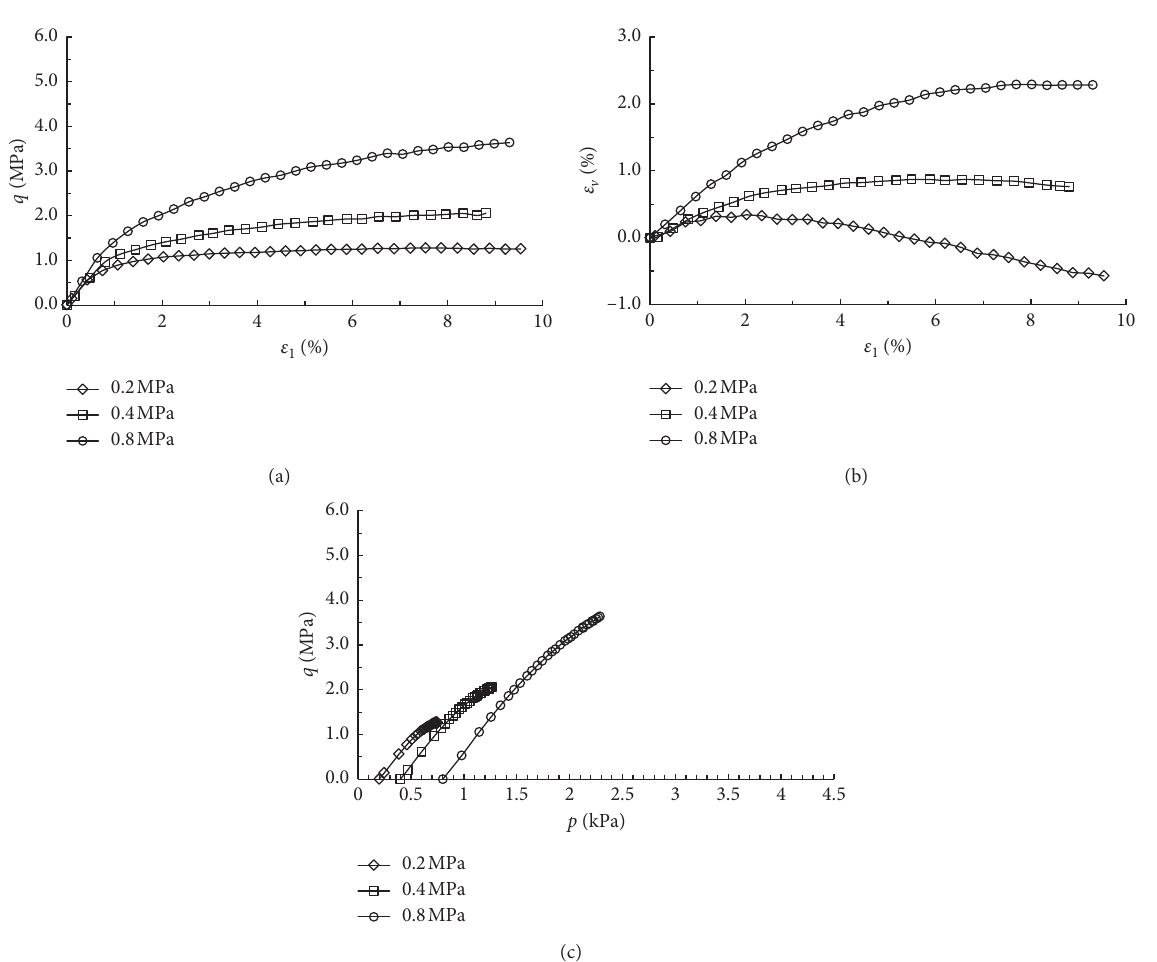
� 0.75: (a) stress-strain curves; (b) volumetric strain curves; (c) stress